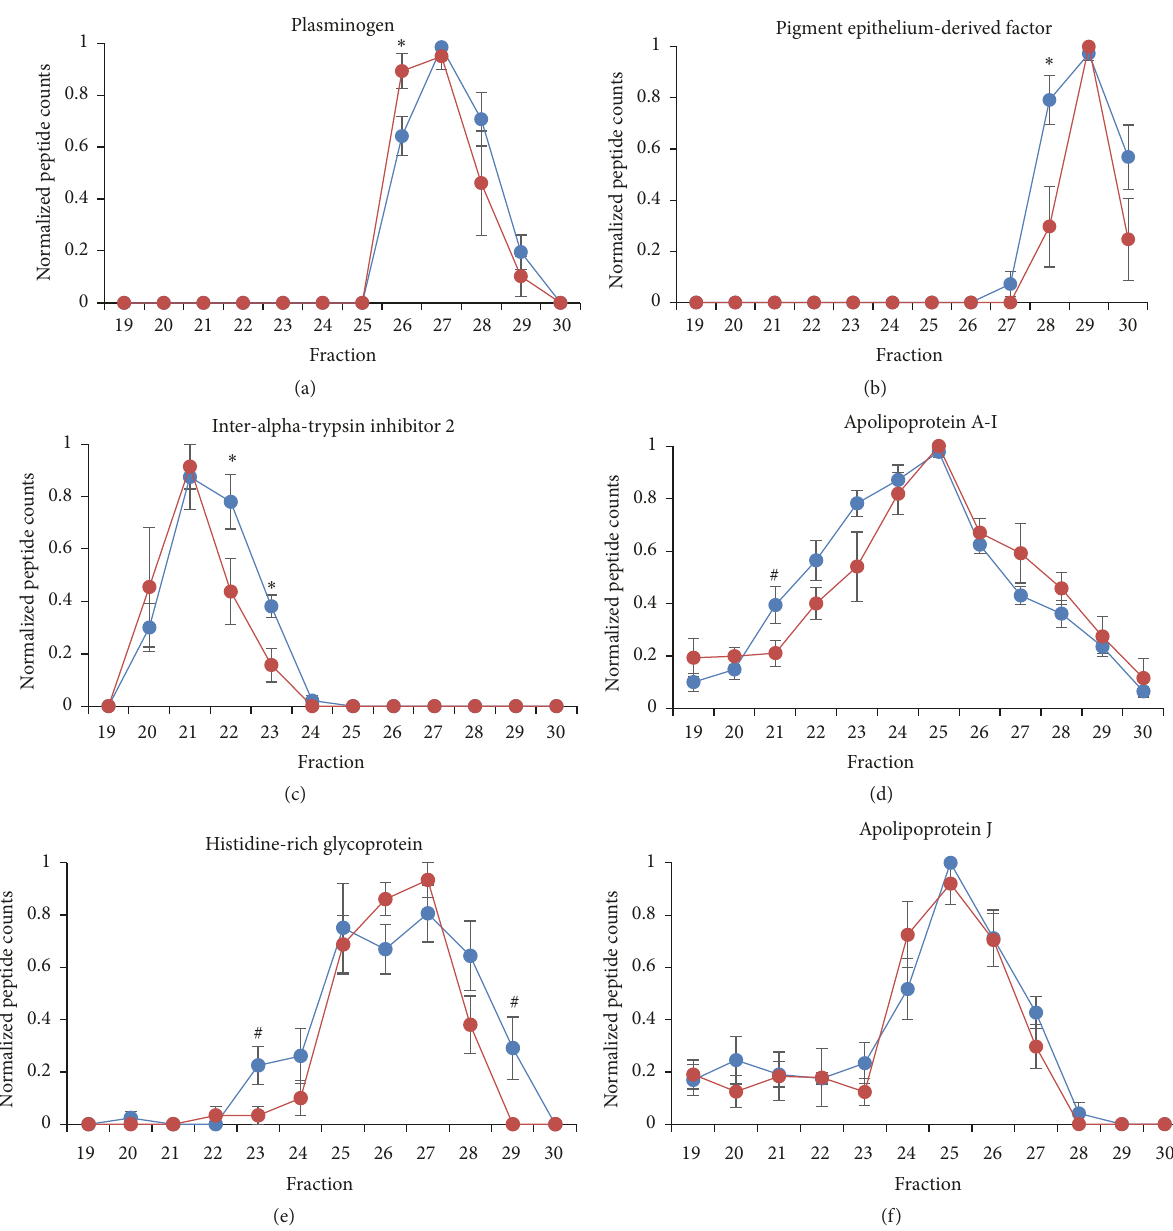
Figure 3: Distribution patterns of example proteins exhibiting high correlations with PWV . Spectral counts were normalized by dividing by the maximum value across all fractions. Data are mean and standard deviation of normalized spectral counts. Normalized peptide counts across the HDL fractions are shown for lean (blue) and T2D (red): (a) plasminogen, (b) pigment epithelium-derived factor, (c) inter-alpha- trypsin inhibitor 2, (d) apoA-I, (e) histidine-rich glycoprotein, and (f) apoJ. A 𝑡 -test was performed for comparing normalized peptide counts between lean and T2D groups at individual fractions. ∗ 𝑃 < 0.05 . # 𝑃 < 0.08